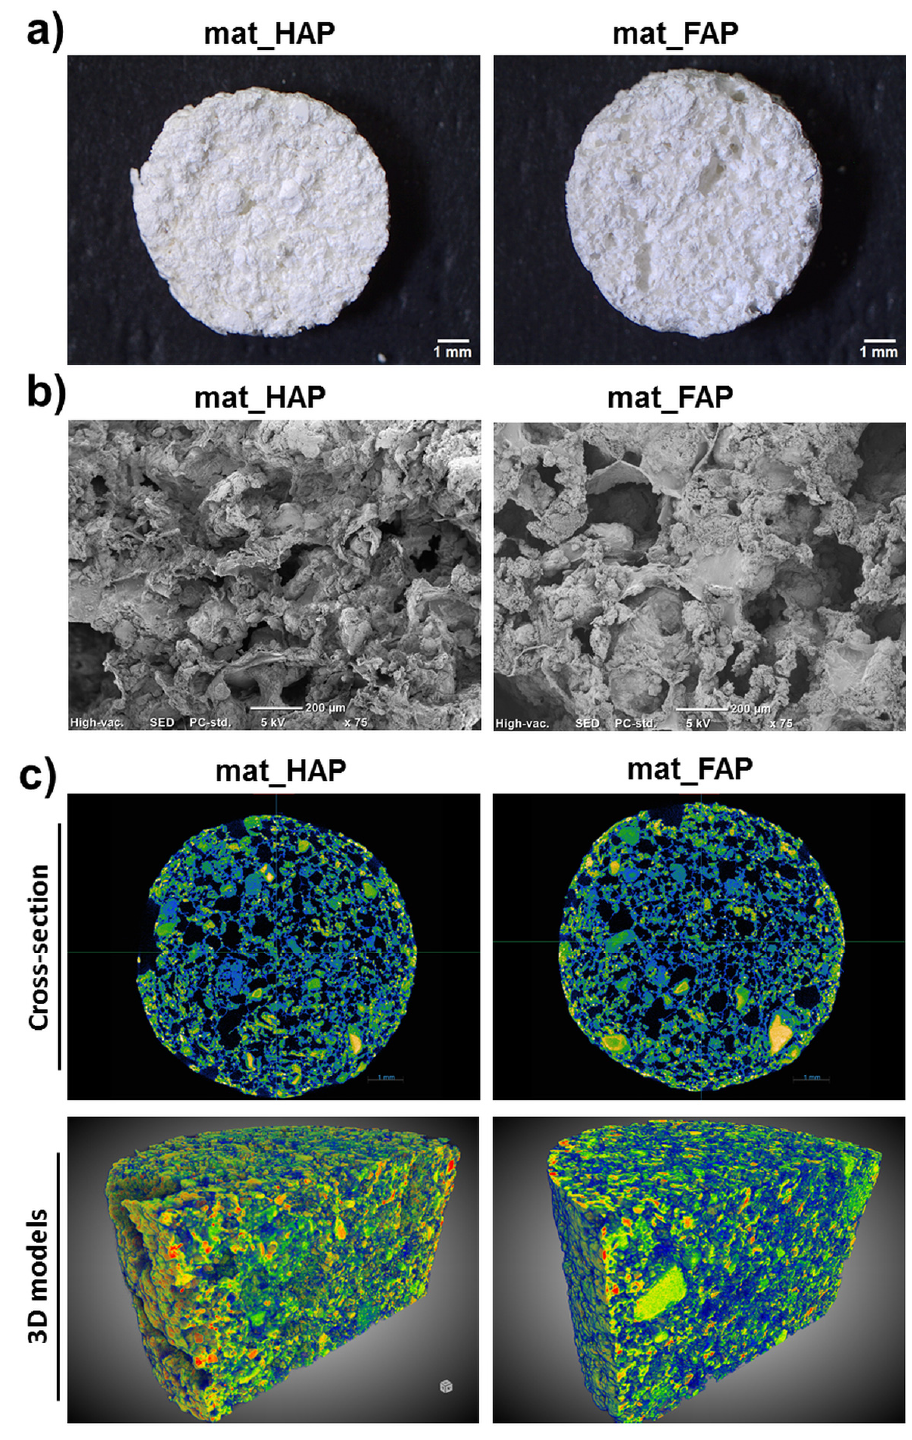
Figure 1. Microstructure evaluation of the apatite-based biomaterials by ( a ) stereoscopic micro- scope, ( b ) scanning electron microscope (SEM), and ( c ) microCT (yellow/green—ceramic; blue— polysaccharide matrix; black color on cross-section images—air voids).